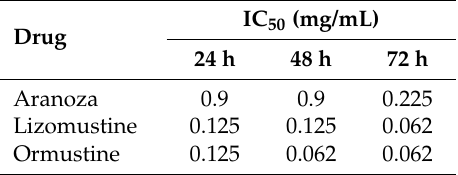
Table 5. Studying influence of nitrosoureas (NUs) on the Mel Z line cells.